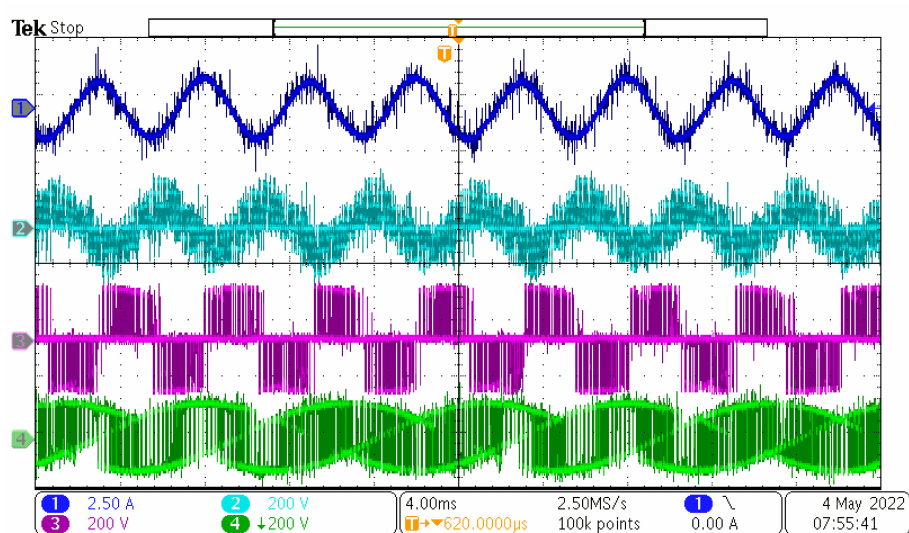
Figure 15. Measured results at f IN = 50 Hz and f OUT = 200 Hz. CH1—output current, CH2—output